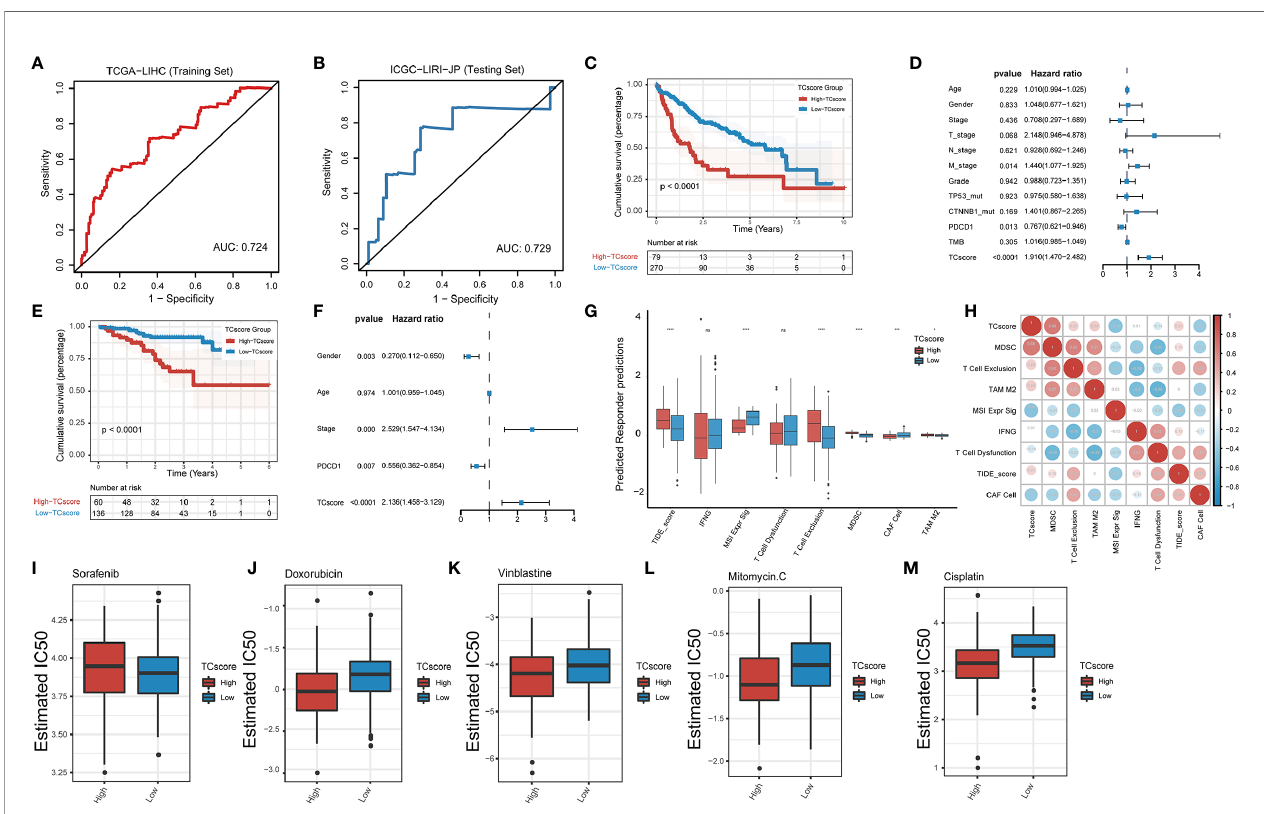
FIGURE 6 | Development of the TCscore based on GSTTKs for the detection of TTK patterns. (A, B) time-dependent ROC analysis shows sensitivity and speci fi city of TCscore in TCGA-LIHC cohort (training set) and ICGC-LIRI-JP cohort (testing set). (C – F) evaluation of prognosis for overall survival based on TCscore for cases from the (C) TCGA-LIHC cohort and (E) ICGC-LIRI-JP cohort. Multivariate Cox regression analyses were performed for patients with HCC from the (D) TCGA-LIHC cohort and (F) ICGC-LIRI-JP cohort. (G) Box plots show the correlation between TIDE score and TCscore in HCC. (H) A Spearman correlation analysis indicated that the TCscore is positively related to the TIDE score. (I – M) Response to four common chemotherapeutics for high and low TCscore in HCC. *p < 0.05; ***p < 0.001; ****p < 0.0001; ns, no statistical signi fi